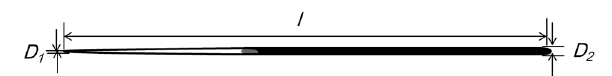
Figure 4. A sketch of the diameter at the upper and lower tip ( D 1 and D 2 ), and length of the needle( l